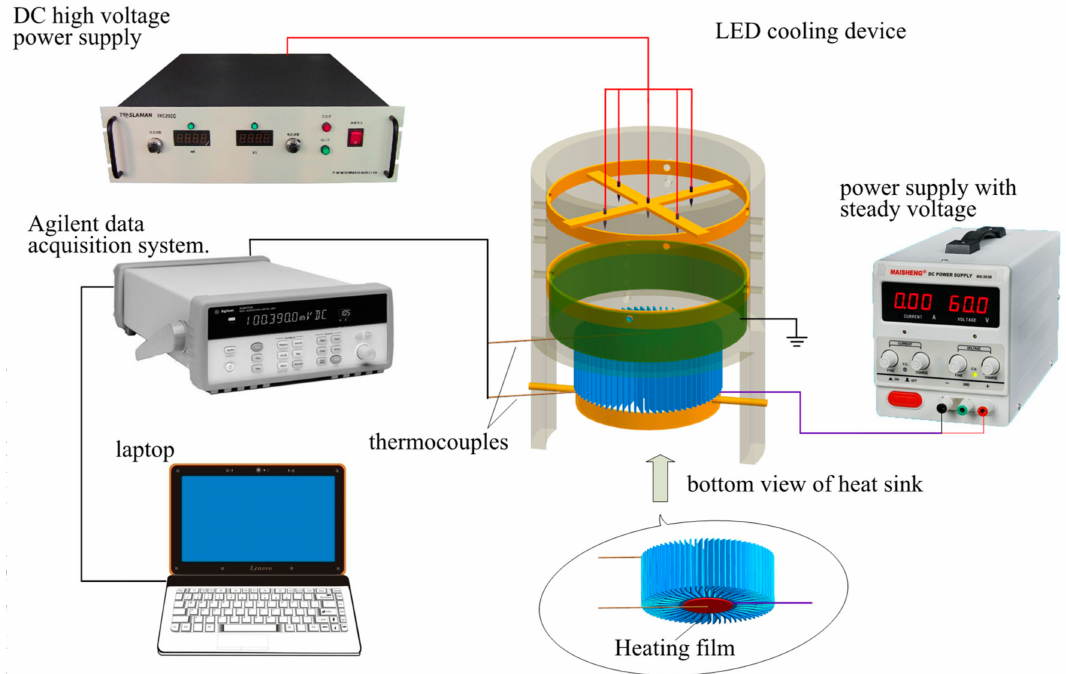
Figure 5. Schematic of the ionic wind velocity testing